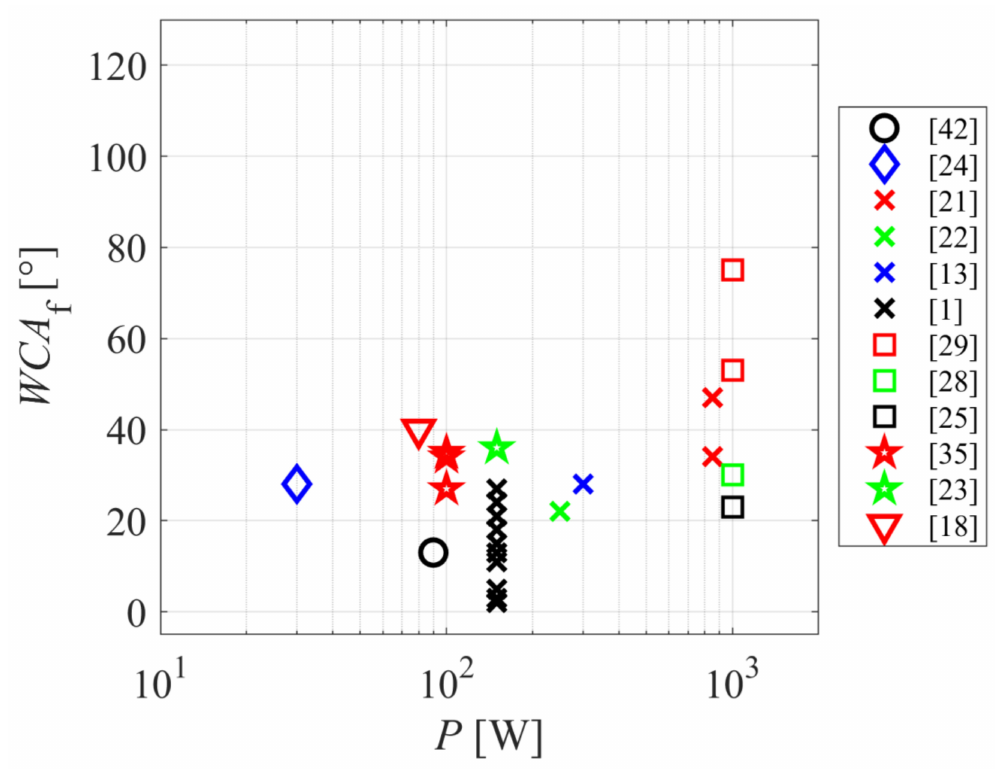
Figure 4. The final water contact angle versus the discharge